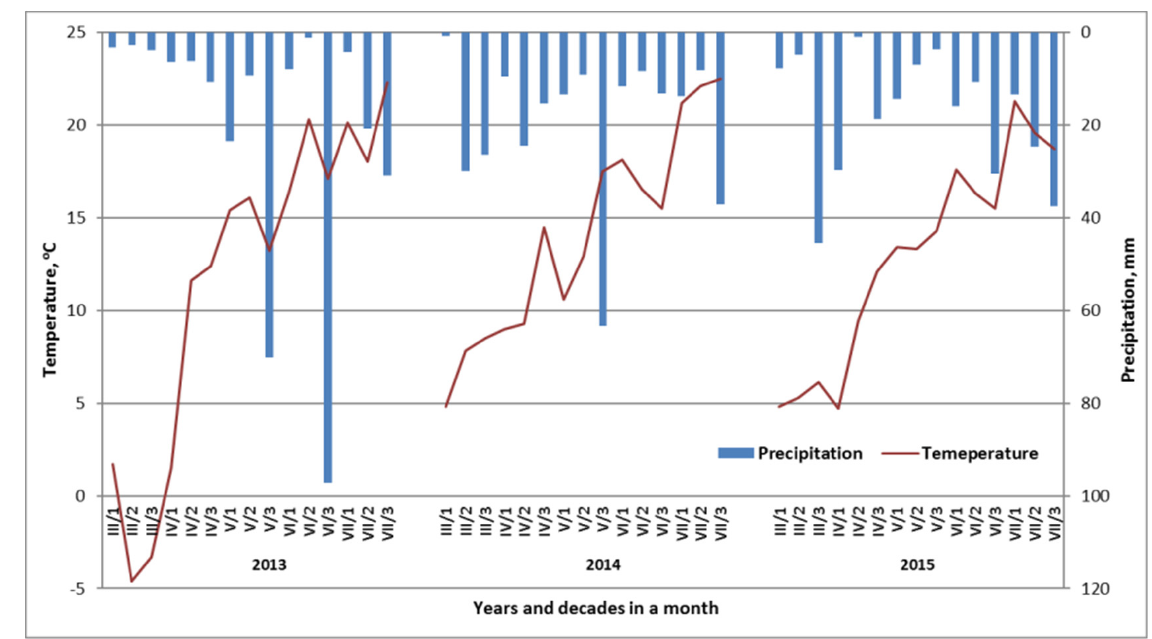
Figure 1. Weather conditions during the consecutive growing seasons.